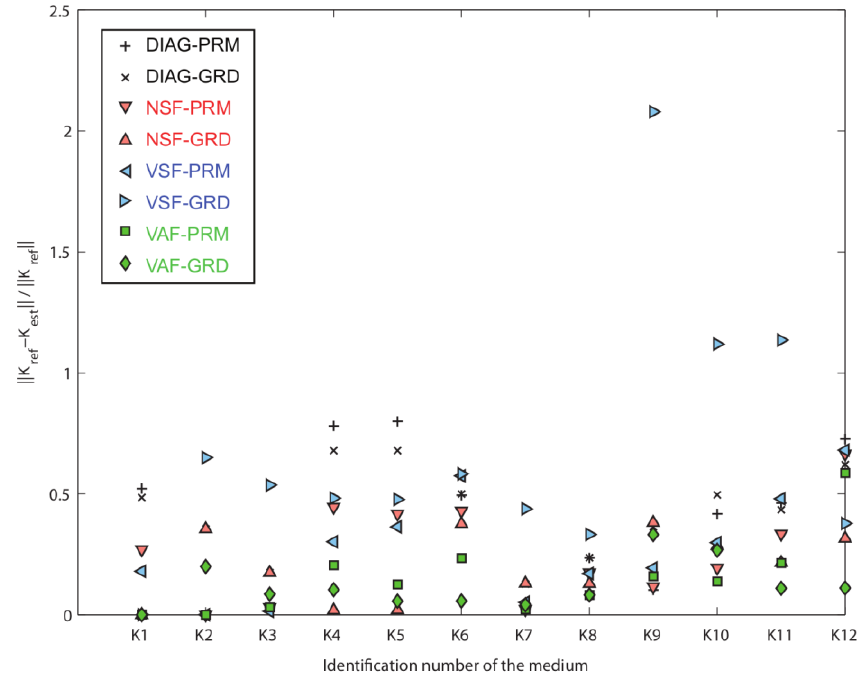
Figure 14. Comparison between the twelve estimated ( K est ) and reference ( K ref ) hydraulic conductivity tensors for the 2D cases; the ordinate represents the normalized Frobenius norm of their difference, and the abscissa represents the different types of media (12 porous samples labeled by their identification number).